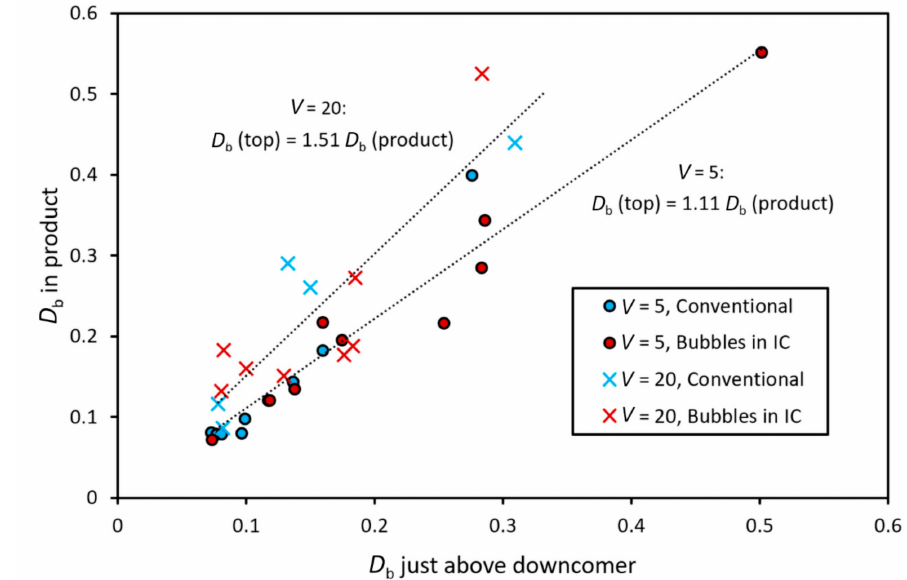
Figure 8. Bubble diameter at product, against bubble diameter just above downcomer, as a measure of coalescence in the upper part of the